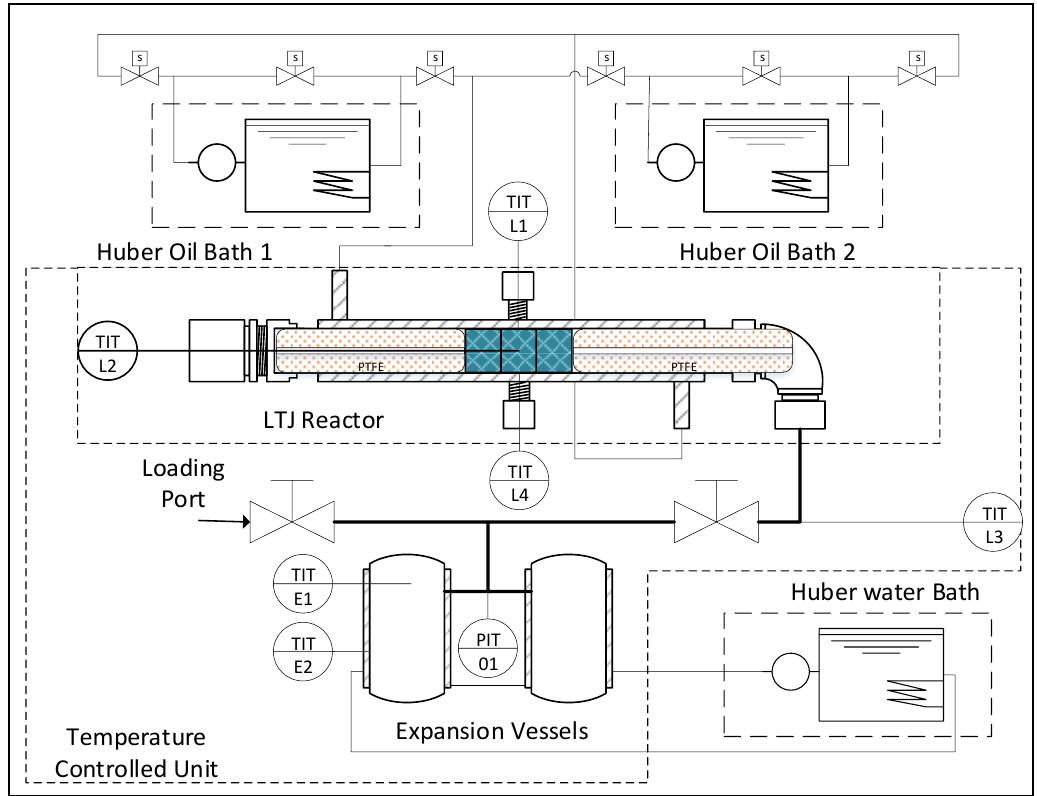
Figure 2. Process flow diagram of the entire LTJ rig.